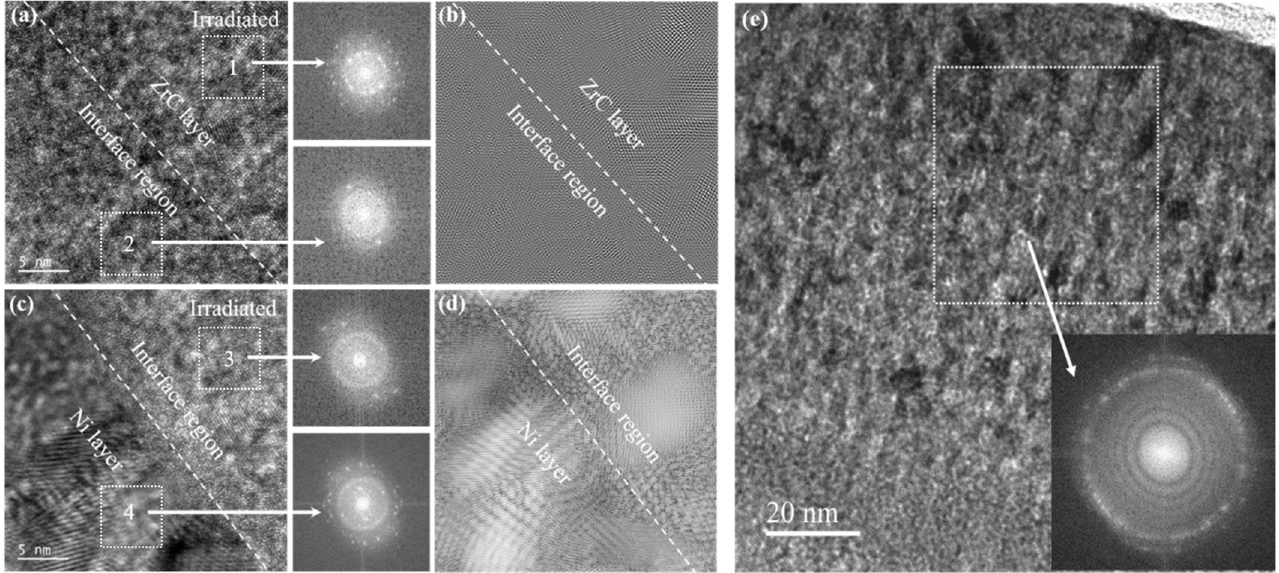
Figure 7. ( a,c ) The HRTEM image with corresponding FFT patterns of the interface on the side of amorphous ZrC and crystalline Ni. ( b,d ) HRTEM image with corresponding FFT patterns of the interface on the side of amorphous ZrC and crystalline Ni. Regions 1, 2, 3, and 4 in the white dashed frames are operated by the FFT transformation. ( e ) The bright-field TEM image with corresponding FFT patterns of ZrC layer after TEM electron-beam focusing for 1.5 h.